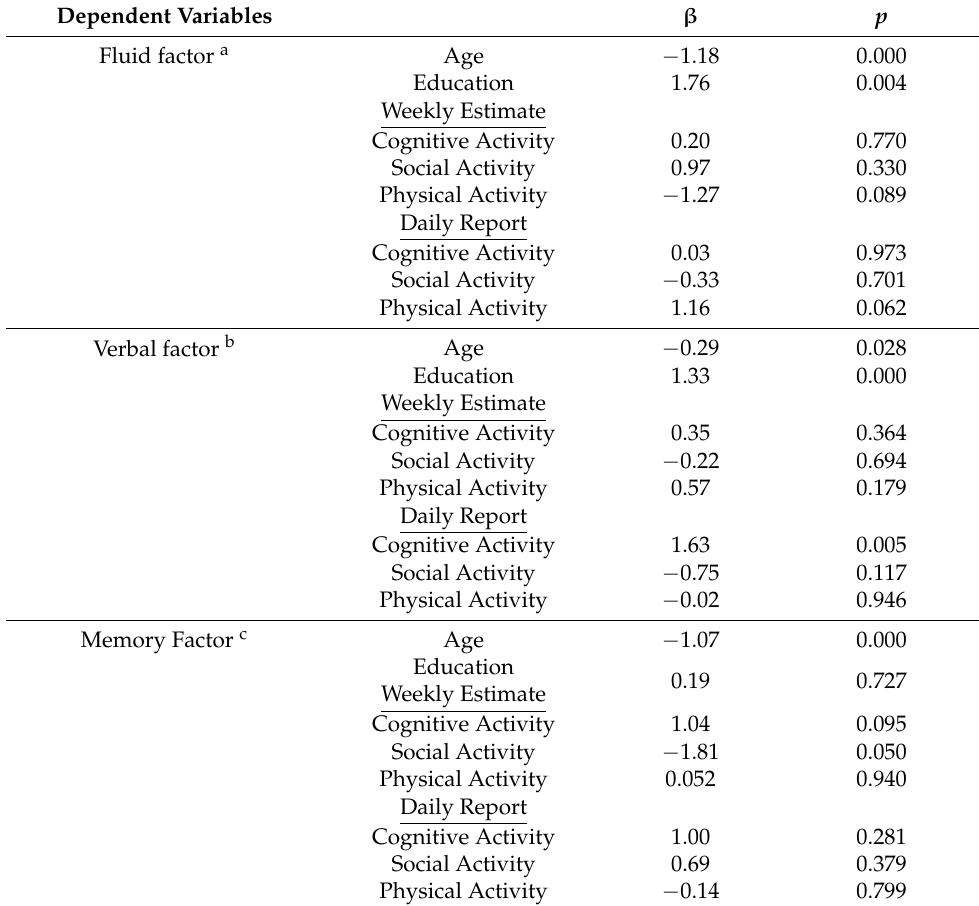
Table 4. Multivariate Multiple Regression Standardized Coefficients for Weekly and Daily Activity Domains, Age, and Education Predicting Cognitive